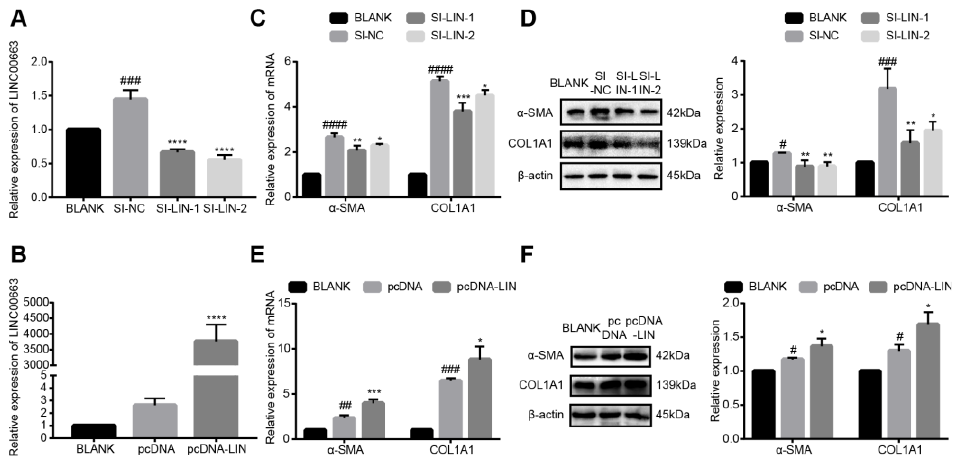
Figure 3. LINC00663 regulated activation of LX-2 cells. LINC00663 expression in LX-2 cells trans- fected with ( A ) si-LINC00663 (SI-LIN-1 and SI-LIN-2) and ( B ) pcDNA-LINC00663 (pcDNA-LIN). Relative expression of α -SMA and COL1A1 in LX-2 cells transfected with si-LINC00663 detected by ( C ) RT-qPCR and ( D ) WB. Relative expression of α -SMA and COL1A1 in LX-2 cells transfected with pcDNA-LIN detected by ( E ) RT-qPCR and ( F ) WB. * p < 0.05, ** p < 0.01, *** p < 0.001, **** p < 0.0001. # p < 0.05, ## p < 0.01, ### p < 0.001, #### p < 0.0001. * vs. NC, # vs. BLANK. Each experiment was repeated three times and similar results were obtained. COL1A1, collagen type I alpha 1 chain; HSCs, hepatic stellate cells; RT-qPCR, real-time quantitative PCR; si, small interfering RNA; α -SMA, α -smooth muscle actin; WB, western blot.